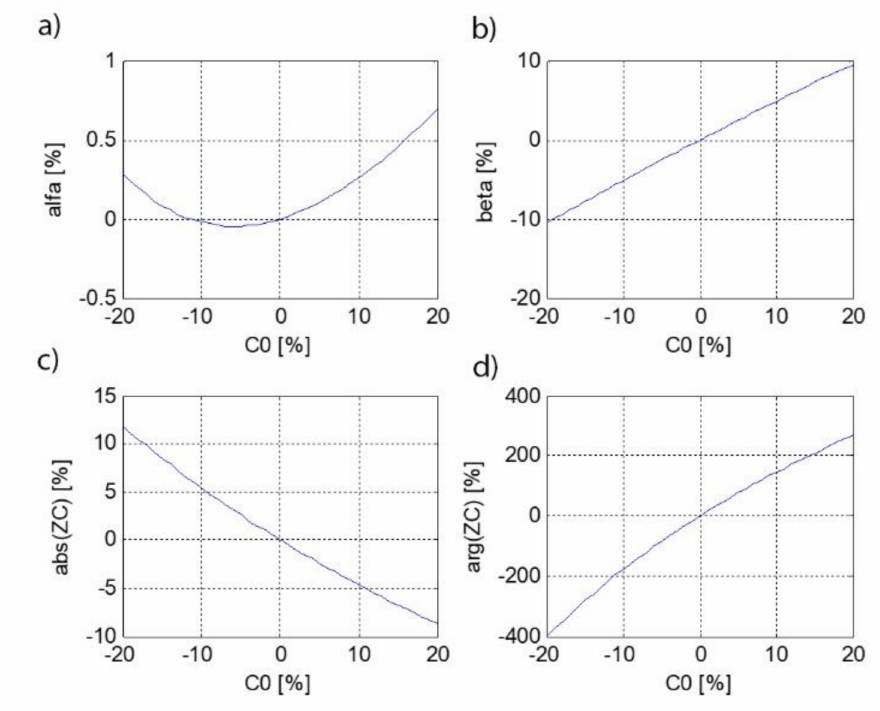
Figure 10. Changes of wave parameters depending on C 0 at f = 1 MHz; ( a ) damping factor α , ( b ) phase factor β , ( c ) wave impedance modulus, and ( d ) wave impedance argument. Changes to the damping factor alpha when changing the G 0 parameter are non − linear, and vary from 1% to 0.2% regardless of frequency (Figures 11a, 12a and 13a). The factor β rises almost linearly from − 10% to 10%, regardless of frequency (Figures 11b, 12b and 13b). The impedance modulus rises almost linearly in the range of − 10% to 10% for